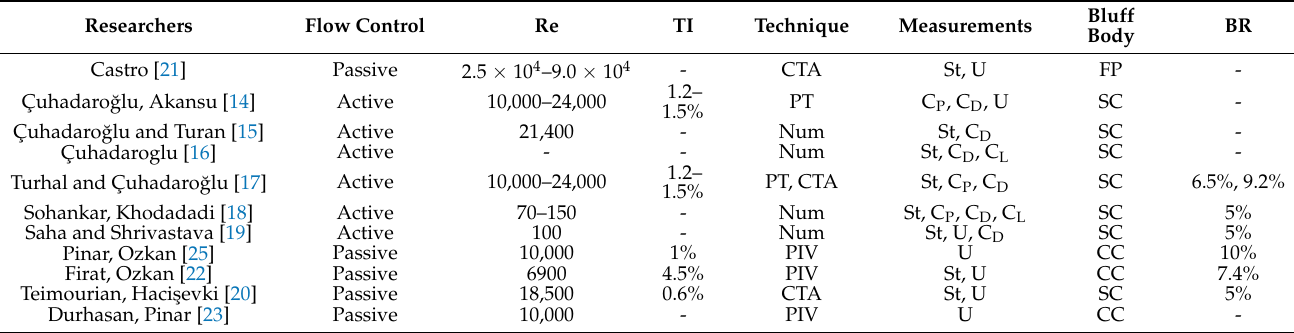
Table 1. Selected studies on flow control and suppression of vortex shedding by employing perforated bluff bodies.